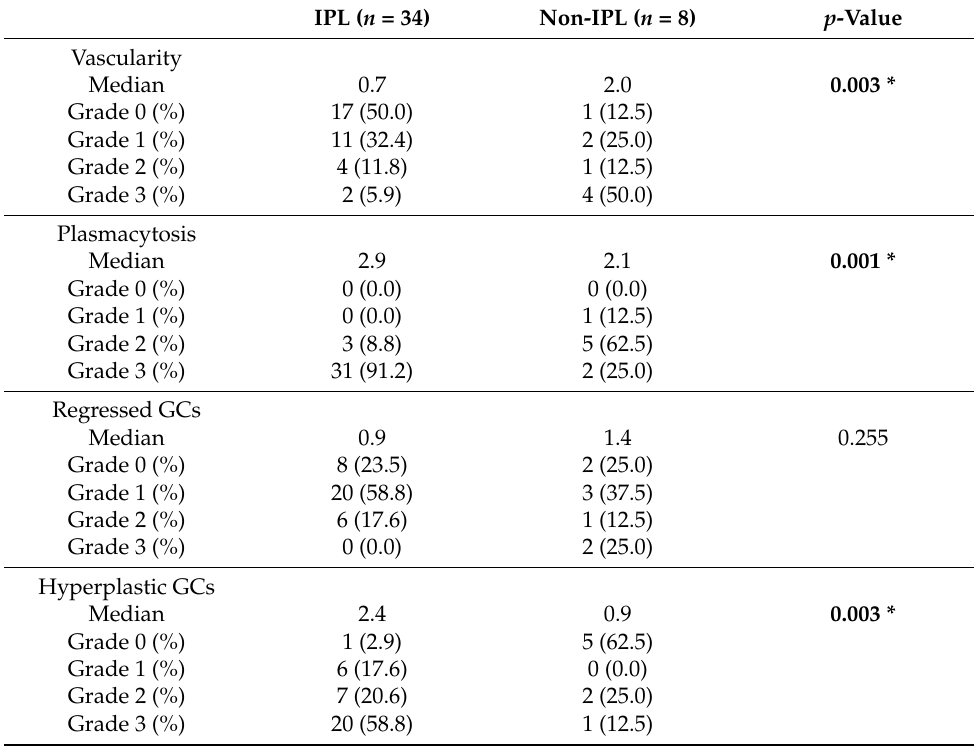
Table 2. Pathological findings of